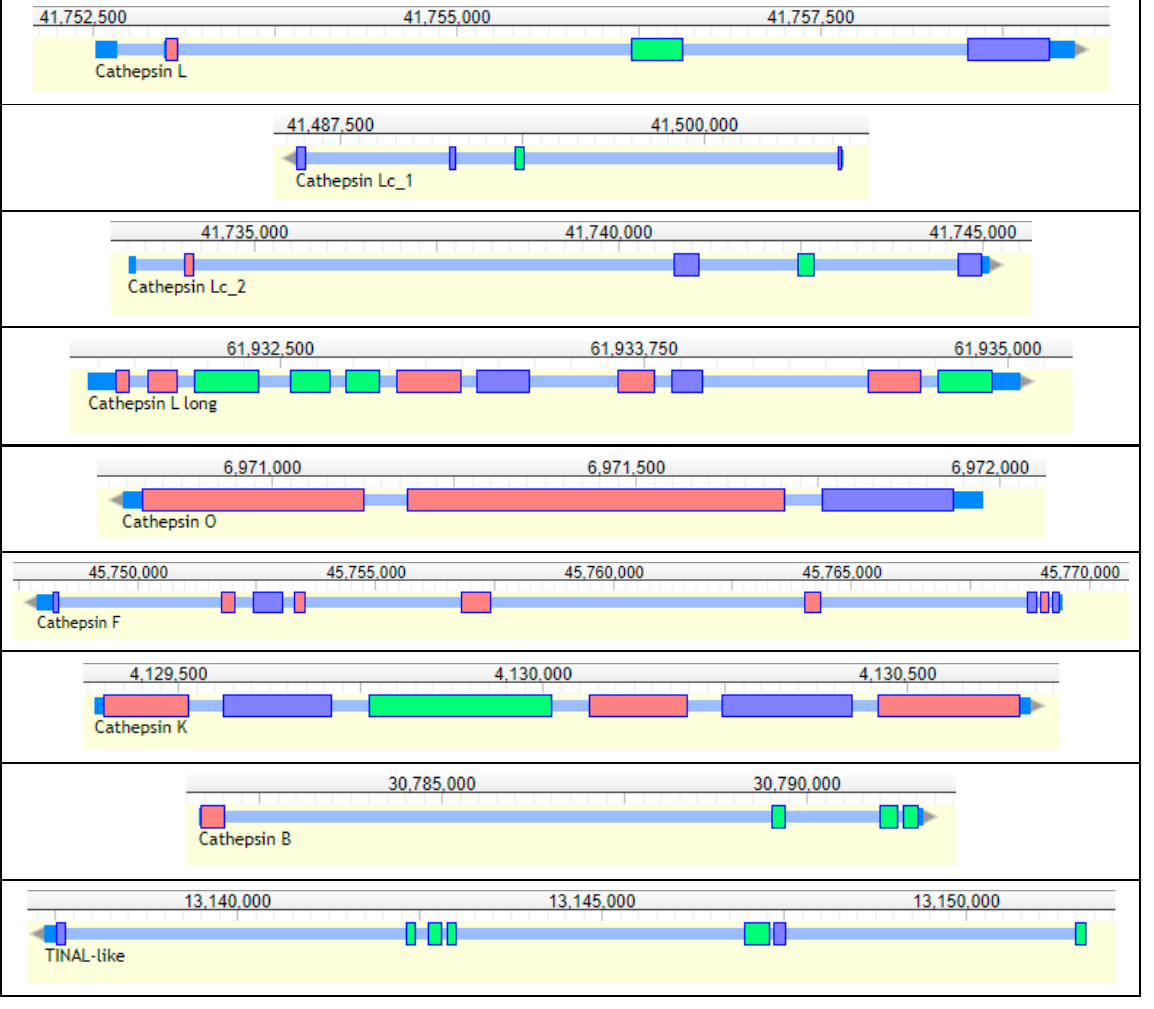
Figure 11. Structure of R. dominica cathepsins genes. Short, multicolored rectangles represent exons, tiny blue regions between them represent introns, and terminal dark blue sites represent UTRs. Upper numbers are sequence coordinates in scaffolds.